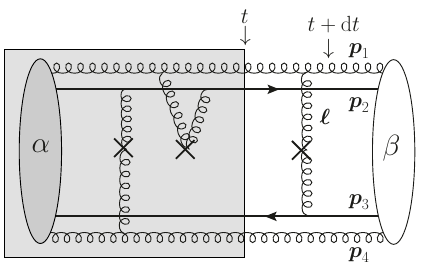
Figure 2 . Generic contribution to the distribution f α β describing the evolution, in transverse → momentum and color space, of an ab parton pair (drawn here for a = g , b = q ). The partons a , b (in the amplitude) and ¯ b , ¯ a (in the conjugate amplitude) are labelled by i = 1 . . . 4, respectively. The scattering between the nucleus and the color singlet ab ¯ b ¯ a system is treated in the two-gluon exchange approximation (nucleons are represented by